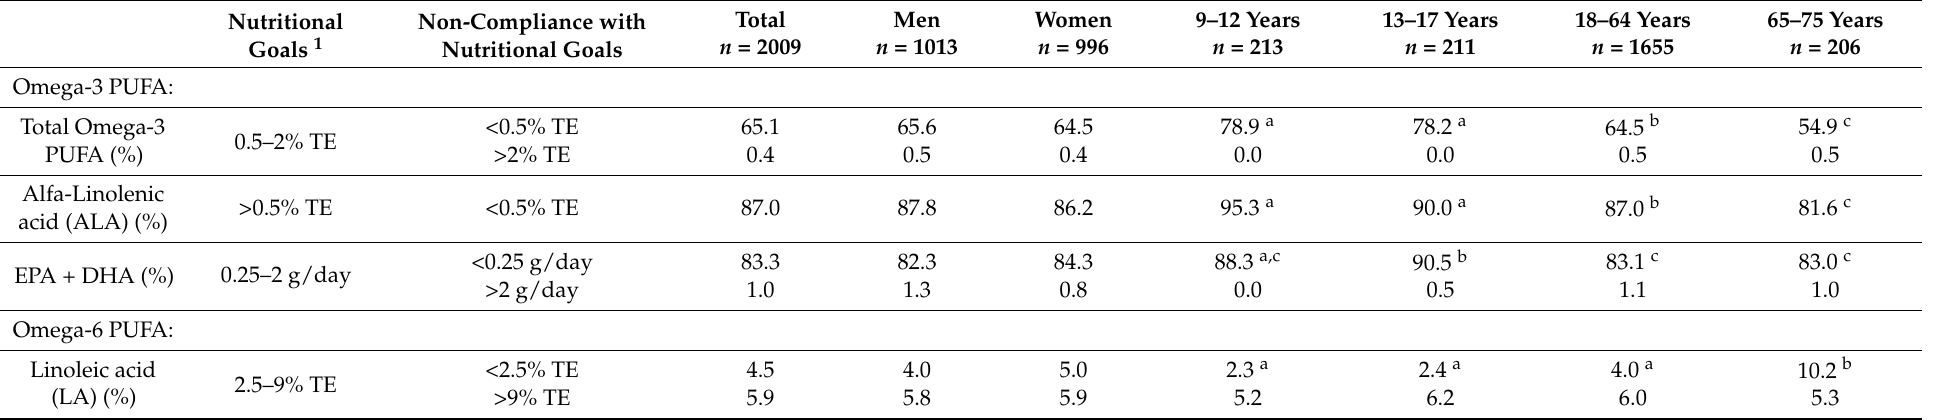
Table 9. Degree of non-compliance with nutritional goals for polyunsaturated fatty acids (PUFA) among the ANIBES Study population. Total Nutritional Non-Compliance with Goals 1 Nutritional Goals